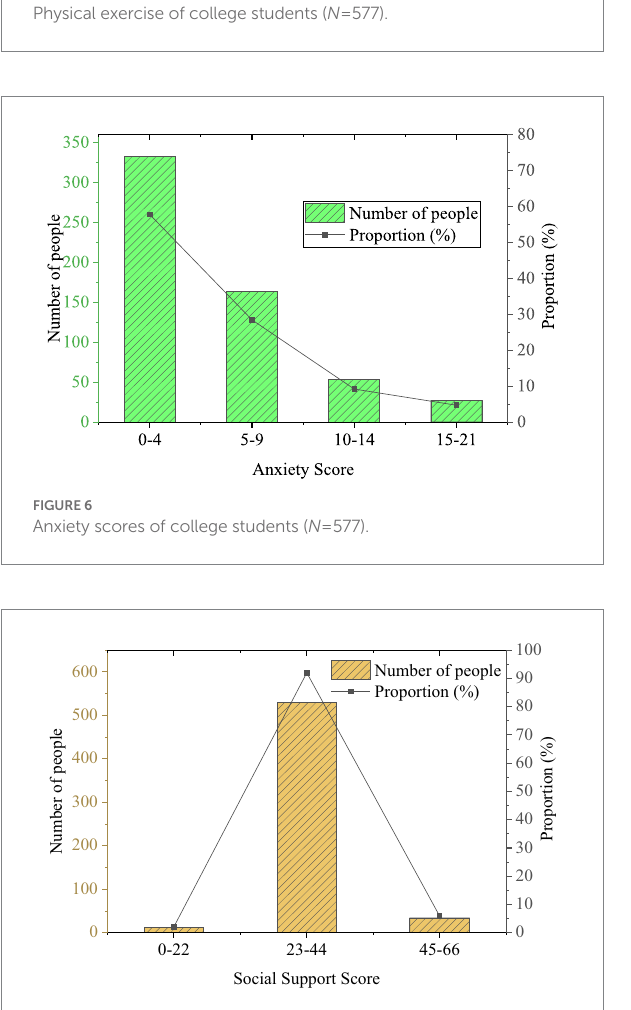
FIGURE 5 Physical exercise of college students ( N = 577).